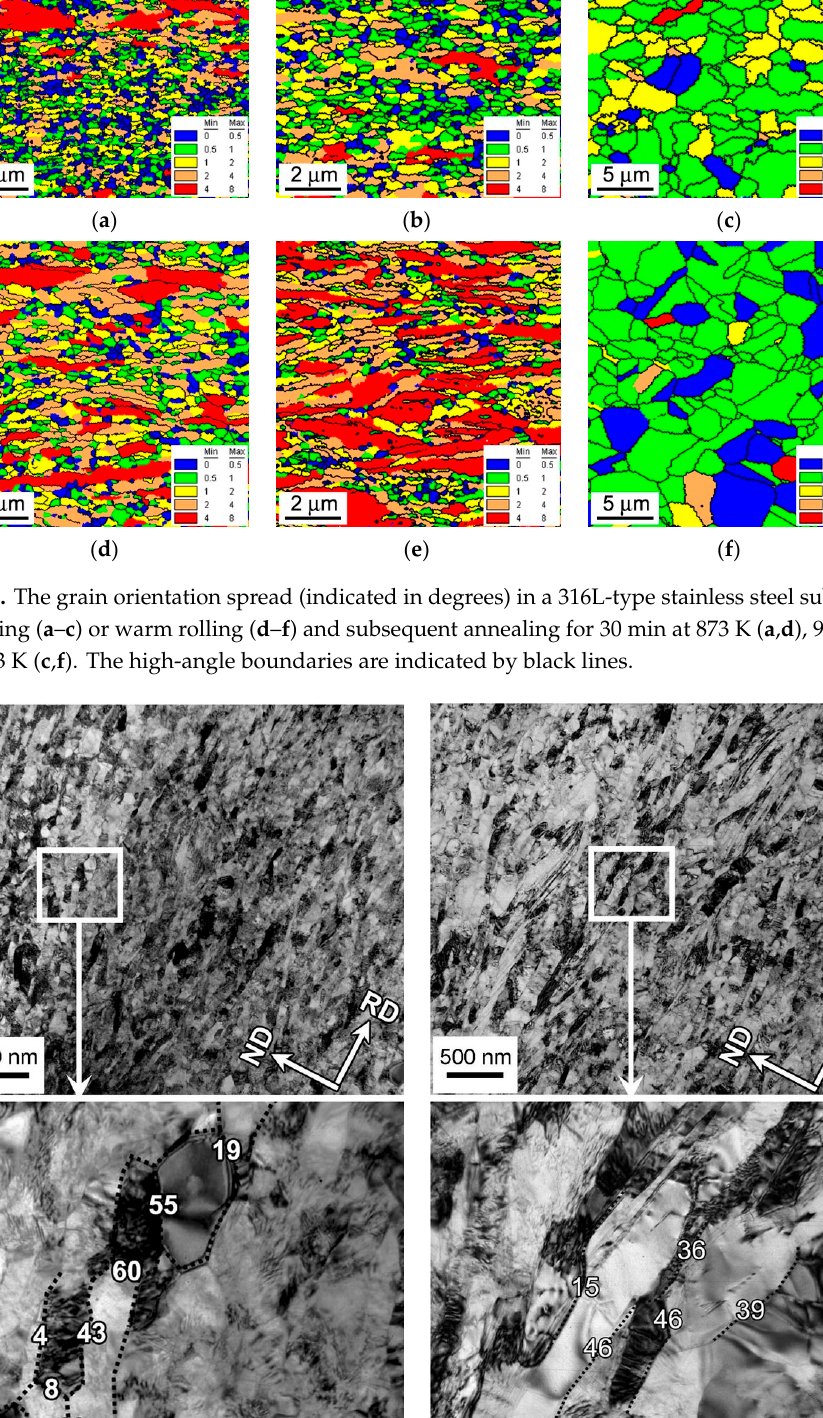
Figure 3. Typical fine structures evolved in a 316L-type stainless steel after cold ( a ) or warm ( b ) rolling and annealing for 30 min at 973 K.